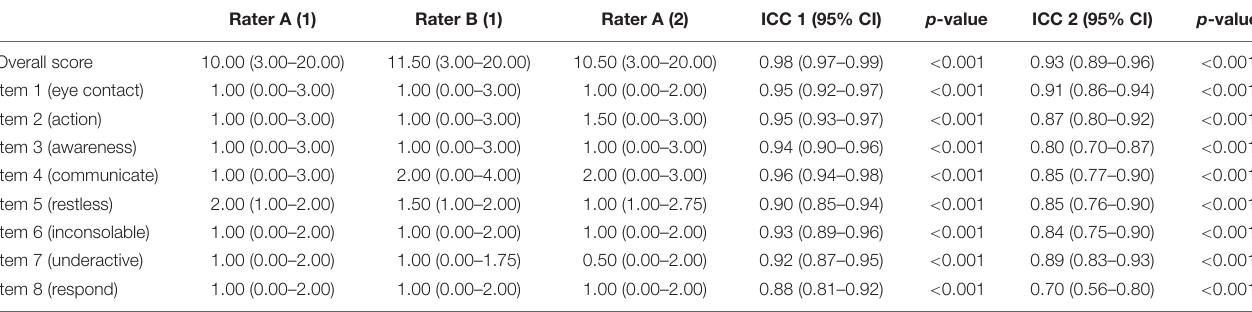
TABLE 2 | CAPD scoring (overall and single item), intra-(ICC 1) and inter-(ICC 2) rater agreement.